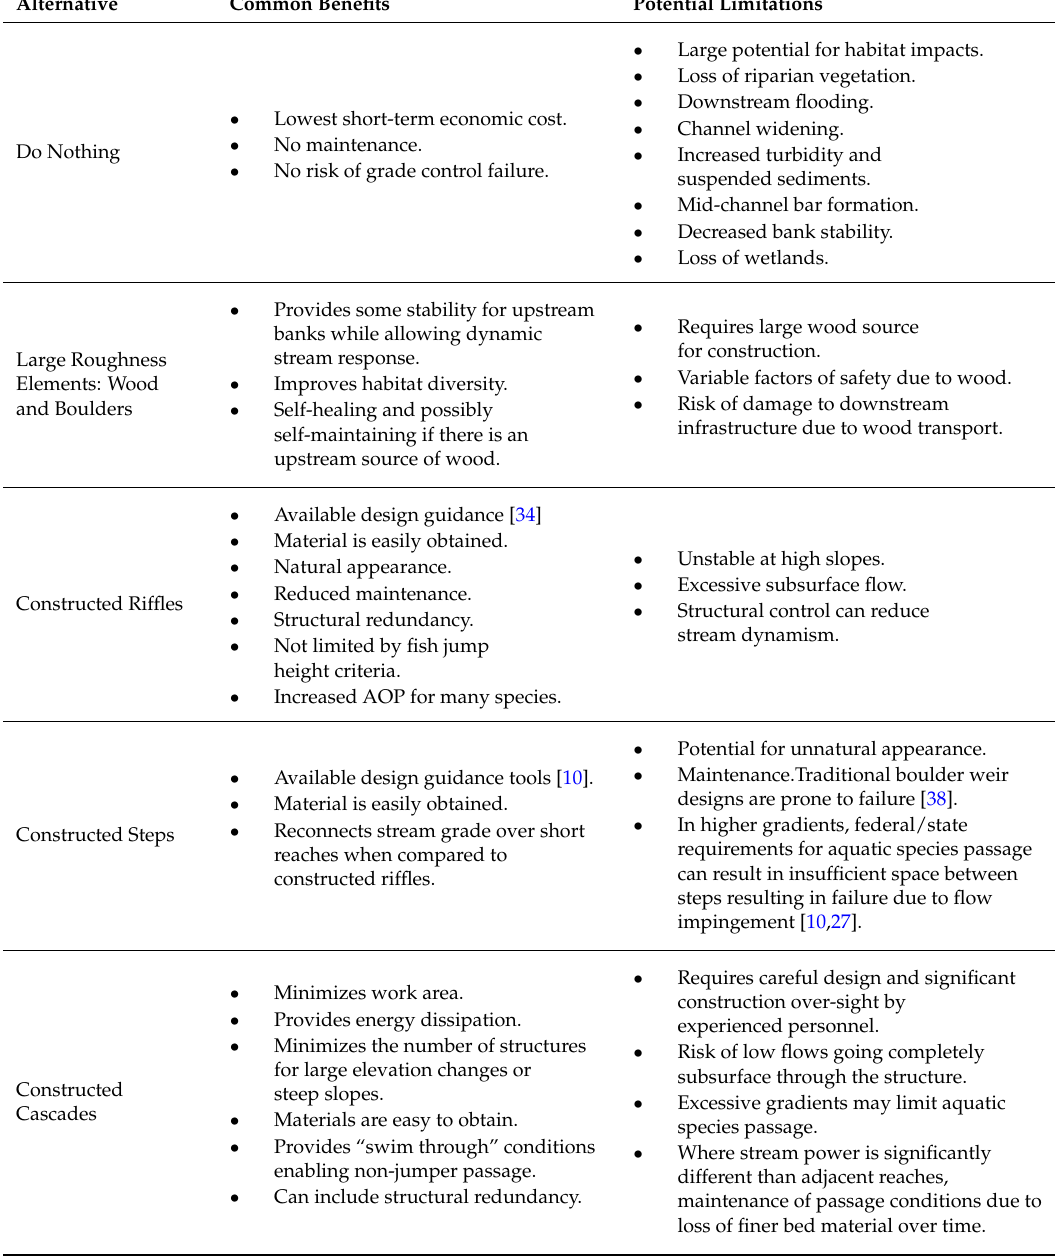
Table 2. Grade Control Treatment Alternative Benefits and